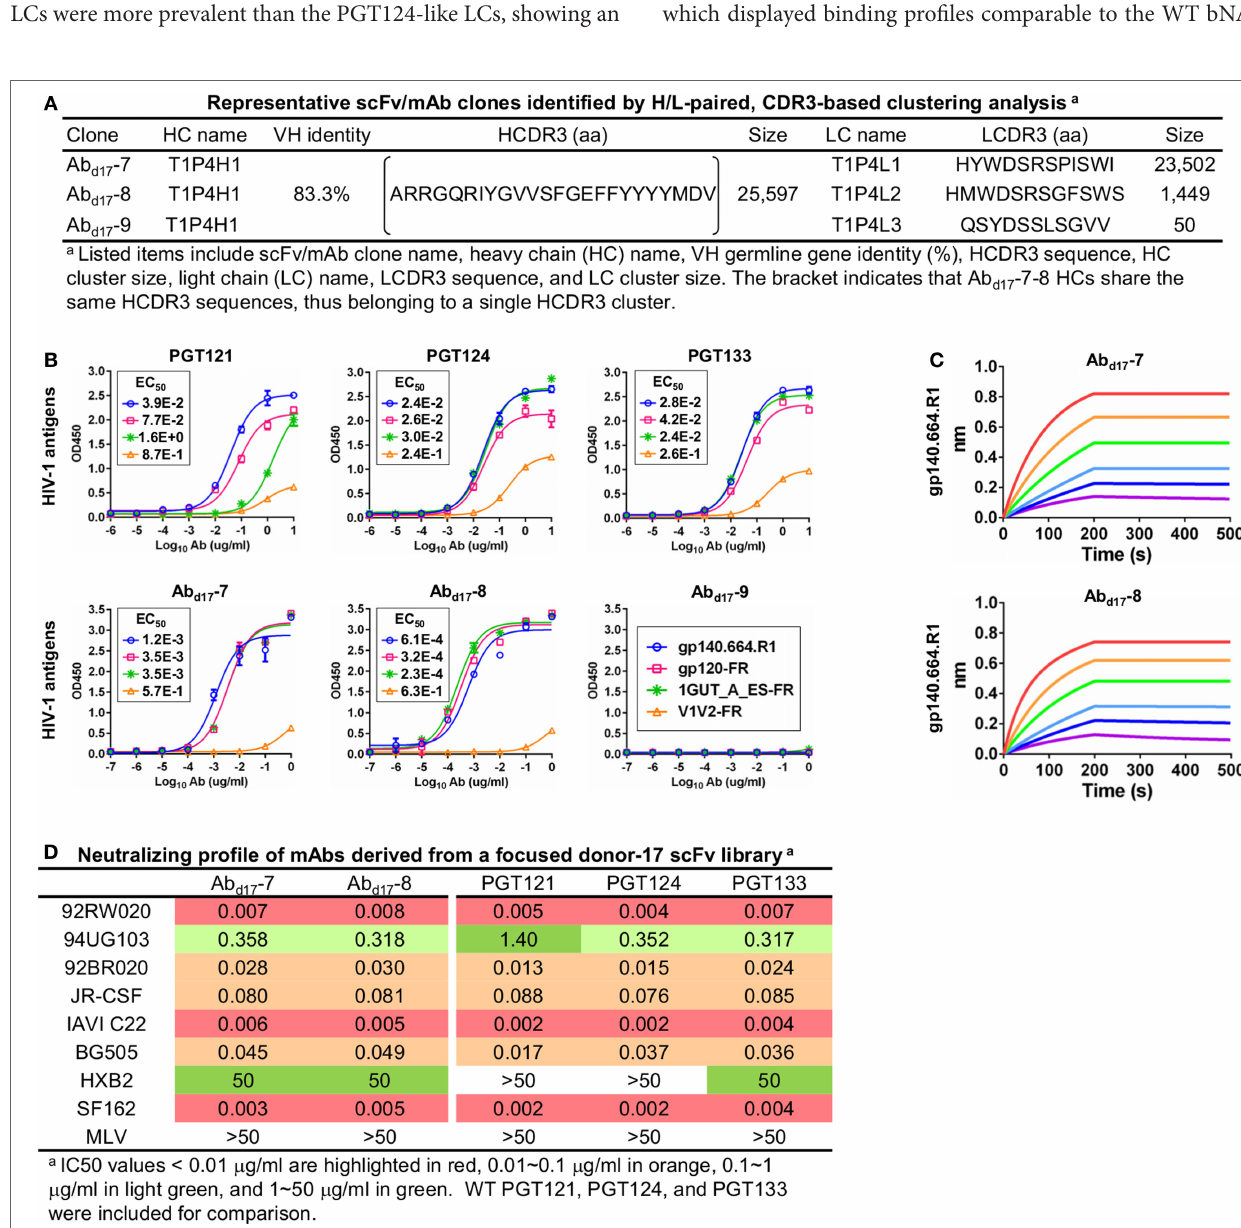
FigUre 6 | Characterization of monoclonal antibodies (mAbs) identified from a focused donor-17 single-chain variable fragment (scFv) library. (a) Representative scFv clones identified from a focused scFv library by H/L-paired, CDR3-based clustering analysis for mAb synthesis. (B) Enzyme-linked immunosorbent assay (ELISA) binding of three broadly neutralizing antibodies (bNAbs) of the PGT121 class (PGT121, 124, and 133) and three scFv-derived mAbs, Ab d17 -7–9, to the gp140.664.R1 trimer and three nanoparticles (gp120-FR, 1GUT_A_ES-FR, and V1V2-FR). EC 50 values are labeled for all ELISA plots except for instances in which the highest OD 450 value is below 0.1 or in the cases of ambiguous data fitting. (c) Octet binding of Ab d17 -7 and -8 to the gp140.664.R1 trimer. Sensorgrams were obtained from an Octet RED96 instrument using a titration series of six concentrations (200–6.25 nM by twofold dilution). (D) Neutralization profiles of Ab d17 -7 and -8 against six tier-2 viruses and two tier-1 viruses, with WT bNAbs PGT121, 124, and 133 included as references. IC 50 values are highlighted based on the same color-coding scheme as in Figure 4c